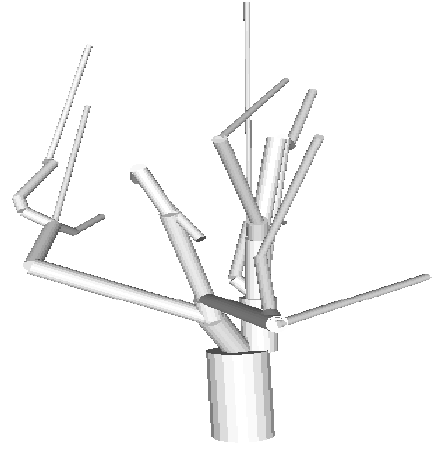
Figure 2. The complete CAD model of a single cherry tree (without leaves).